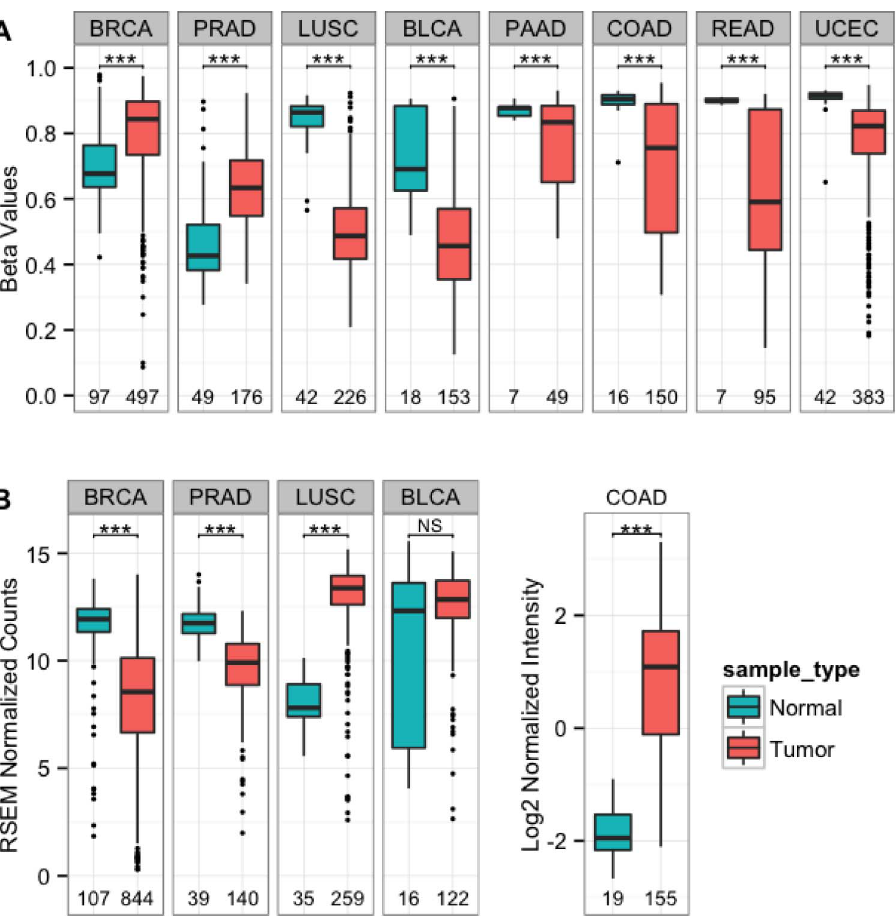
Figure 4. Bidirectional ‘‘switch’’ in TRIM29 regulation from normal epithelium to the respective carcinomas. TCGA data analysis: ( A ) TRIM29 promoter methylation (average of 5 Illumina probes, Table S4B ) in normal and in cancer tissues. Partial methylation was noted in breast and prostate normal tissues that increased in the respective cancers. In contrast, for the other tissue-types, methylation was high in the normal tissues and decreased in the respective carcinomas. ( B ) For breast and prostate cancers, increase in promoter methylation was associated with decrease in gene expression whereas the opposite was noted for the other tissues. BRCA=breast carcinoma, PRAD=prostate adenocarcinoma, LUSC=lung squamous cell carcinoma, BLCA=bladder carcinoma, PAAD=pancreatic adenocarcinoma, COAD=colon adenocarcinoma, READ=rectal adenocarcinoma UCEC=uterine-cervix carcinoma. Number of samples indicated at the bottom, *** p , 0.0001, NS – not significant, P-values between groups were calculated using Welch’s corrected